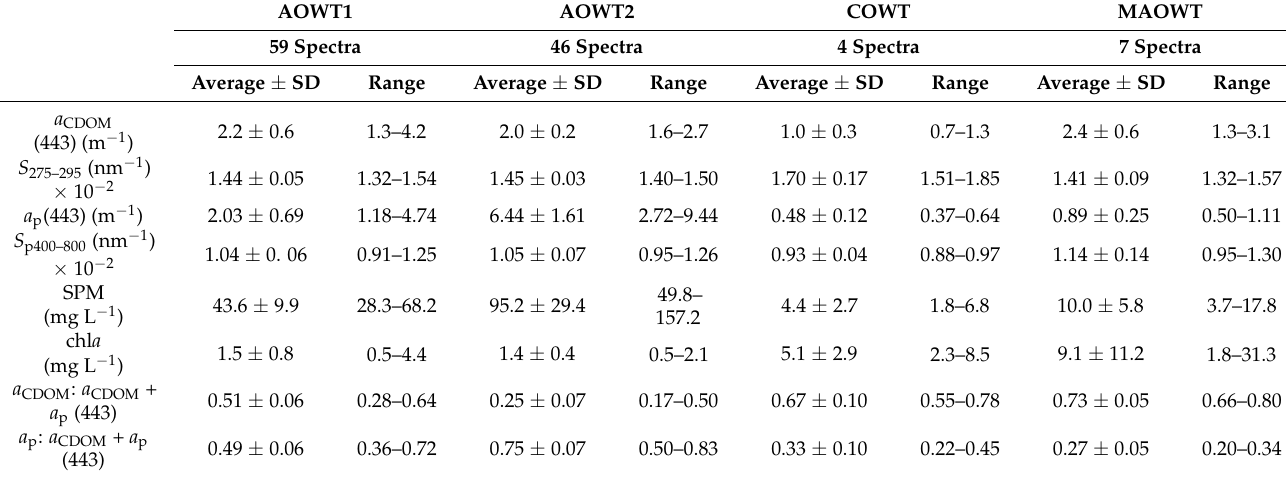
Table 4. Bio-optical characteristics of the four optical water types (OWT) identified for the Lower Amazon region. AOWT1 AOWT2 COWT MAOWT 46 Spectra 4